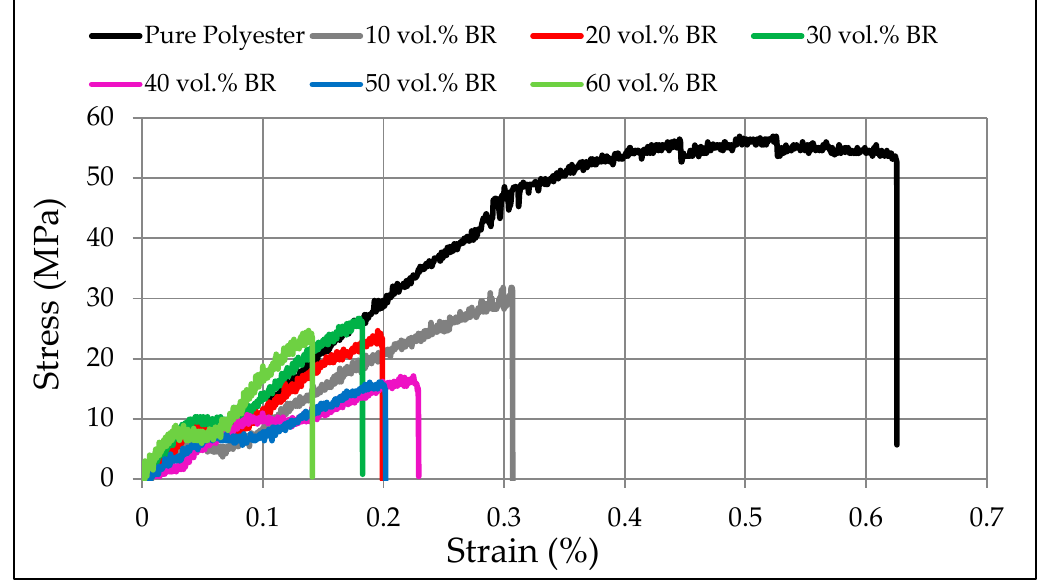
Figure 10. Flexure stress–strain curves of BR–UPR composites.